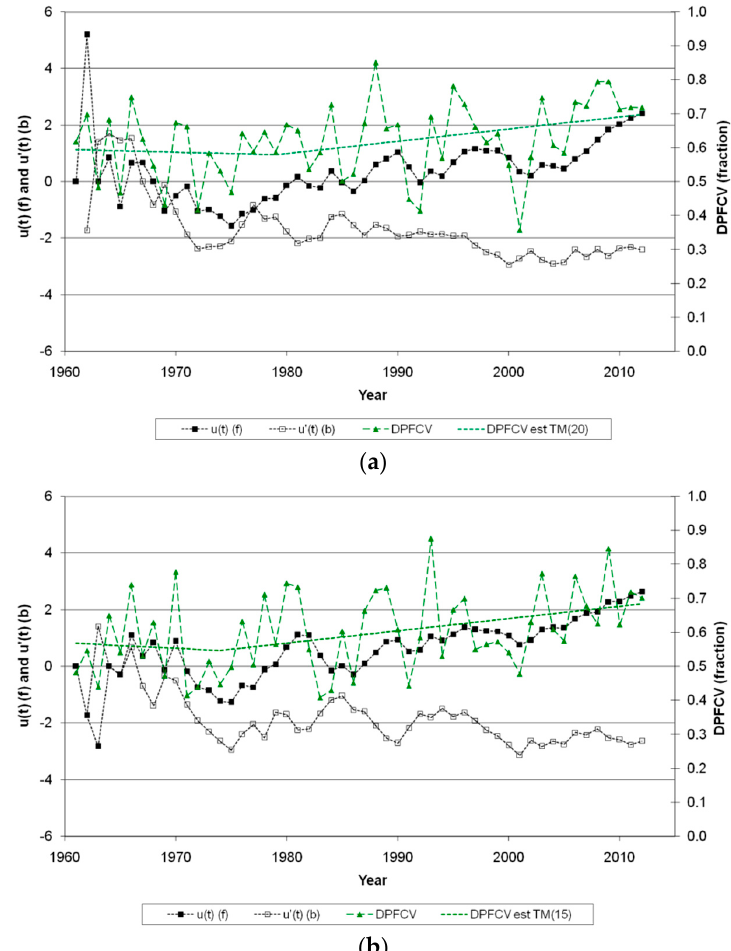
Figure 9. Variation coefficient of annual rainy days (DPFCV) at BO ( a ) and RC ( b ) between 1960 and 2012, and determination of the breakpoint with Mann-Kendall–Sneyers, where u(t) and u’(t) are the forward (f) and backward (b) test values, respectively, and from Tomé–Miranda (TM), where MINIX = 20 for ( a ) and 15 for ( b ).